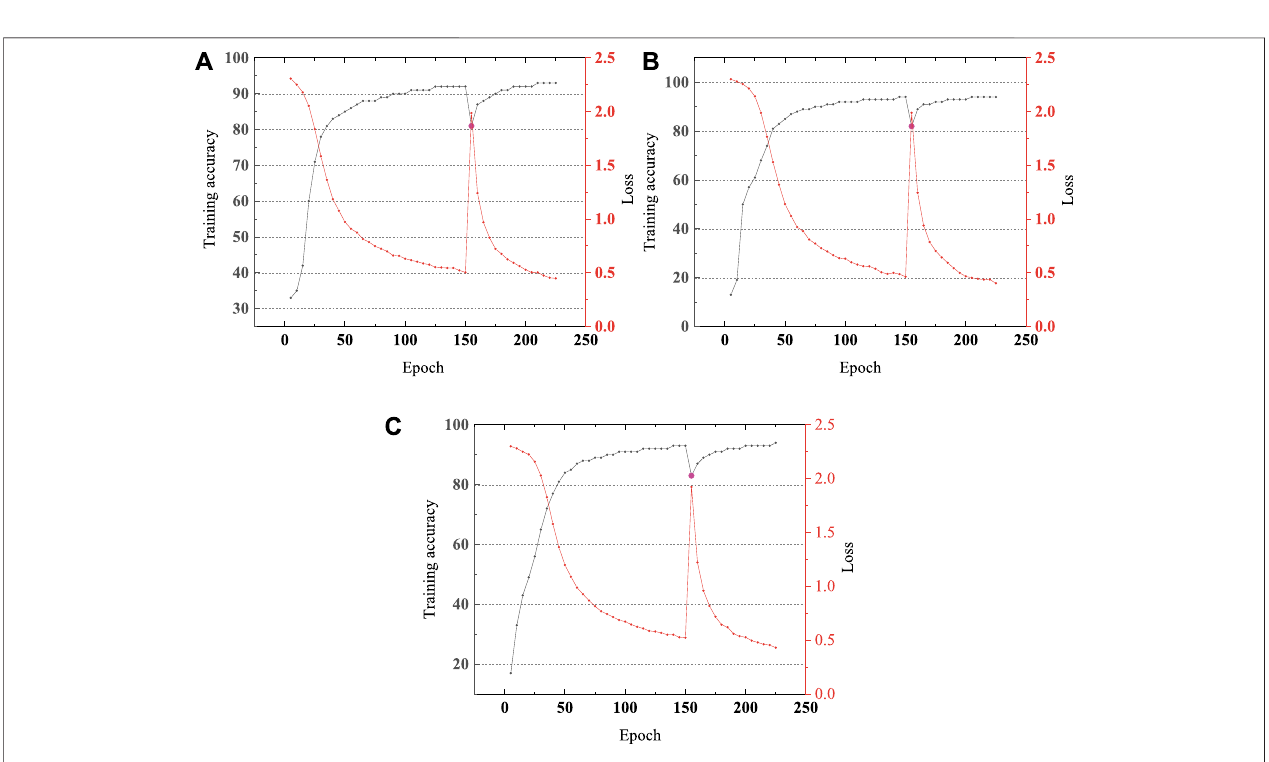
FIGURE 3 | Results of model transfer: (A) N F (cid:1) 10; (B) N F (cid:1) 20; (C) N F (cid:1) 30.